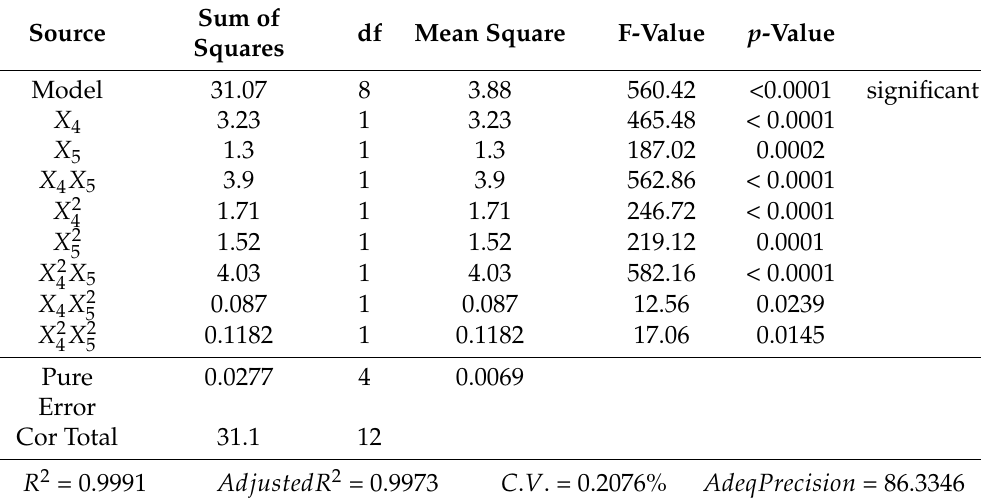
Table 10. ANOVA for Central Composite Design test